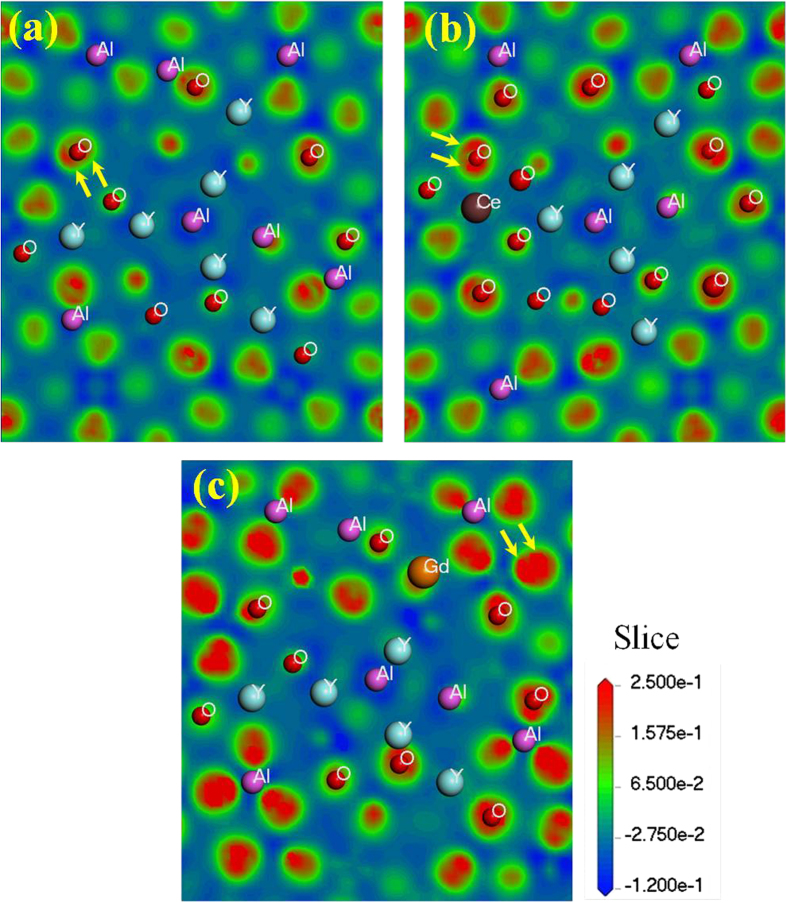
Charge deformation density of Y3Al5O12(a), (Y0.98Ce0.02)3Al5O12 (b), and (Y0.75Gd0.25)3Al5O12 (c) calculated based on DFT.